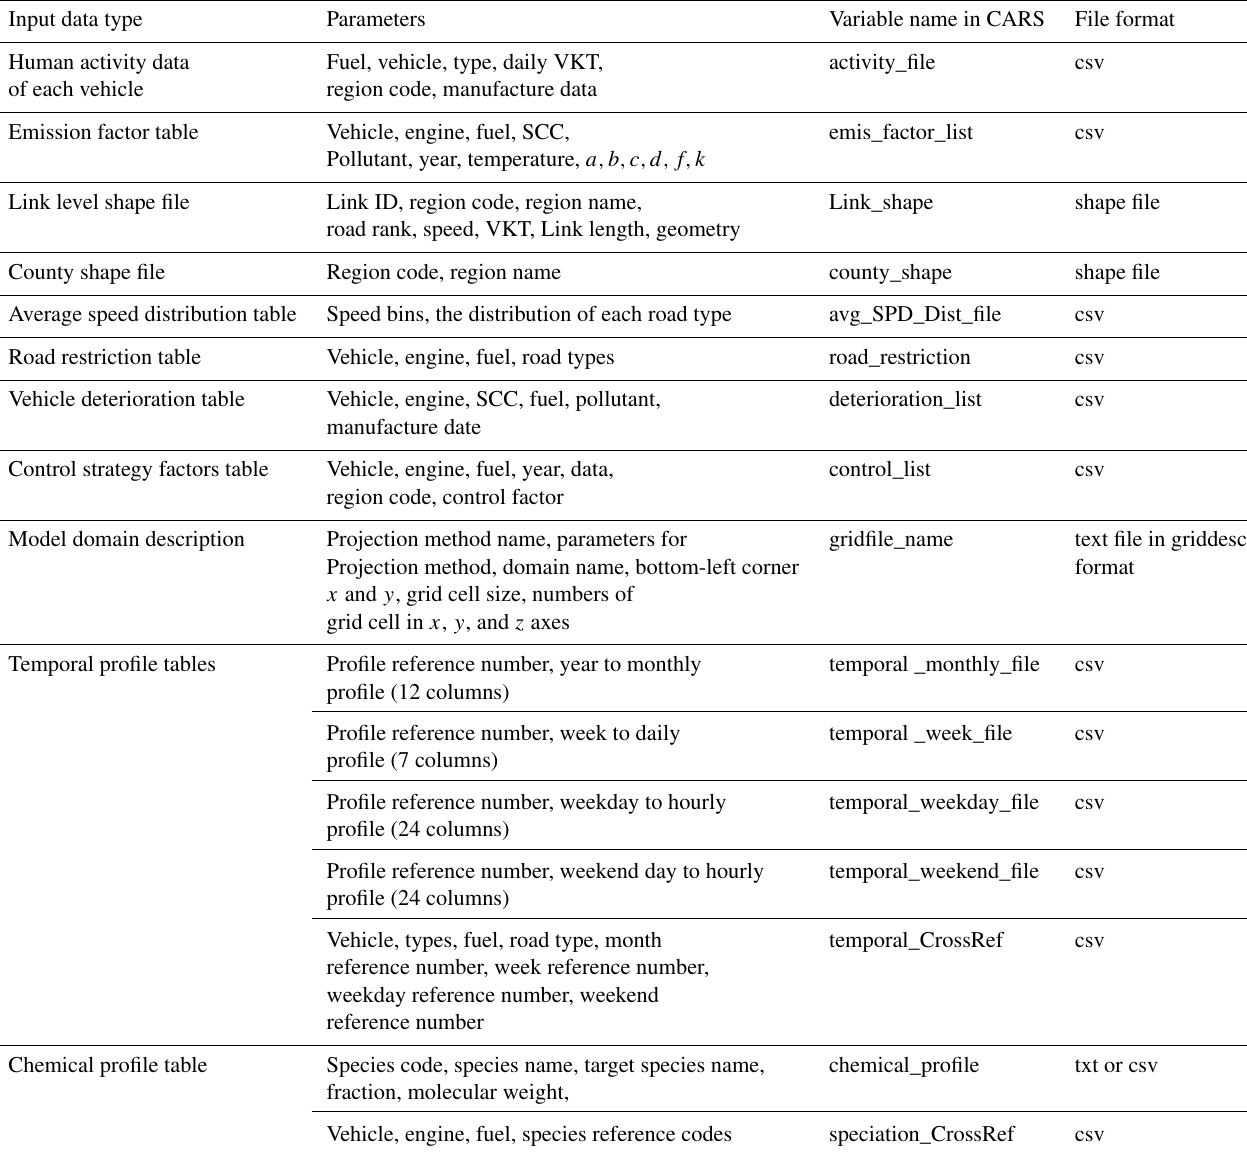
Table H1. CARS model input data summary